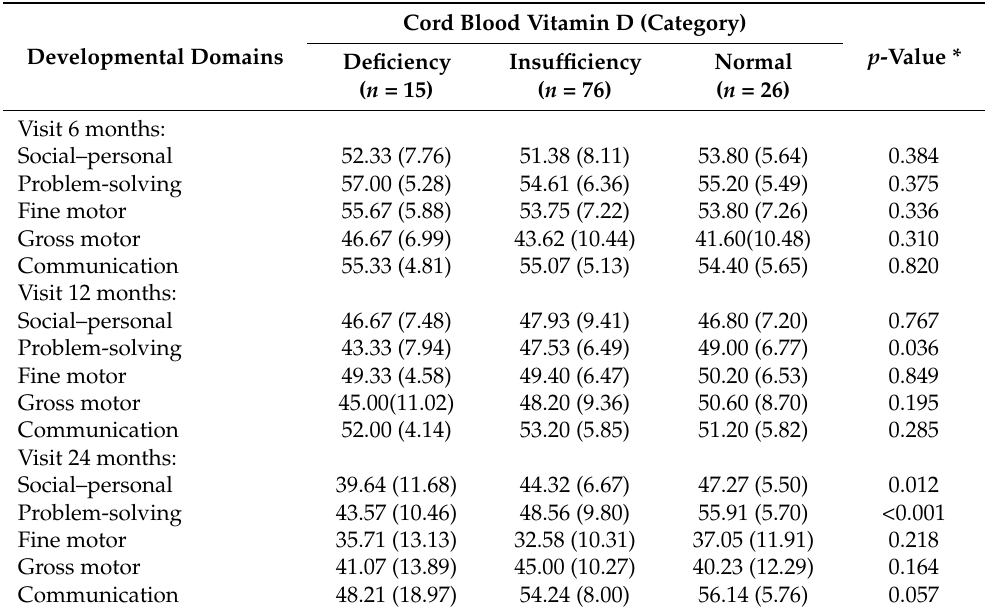
Table 5. Comparison of infant developmental status at three different times of visit based on vitamin D levels.